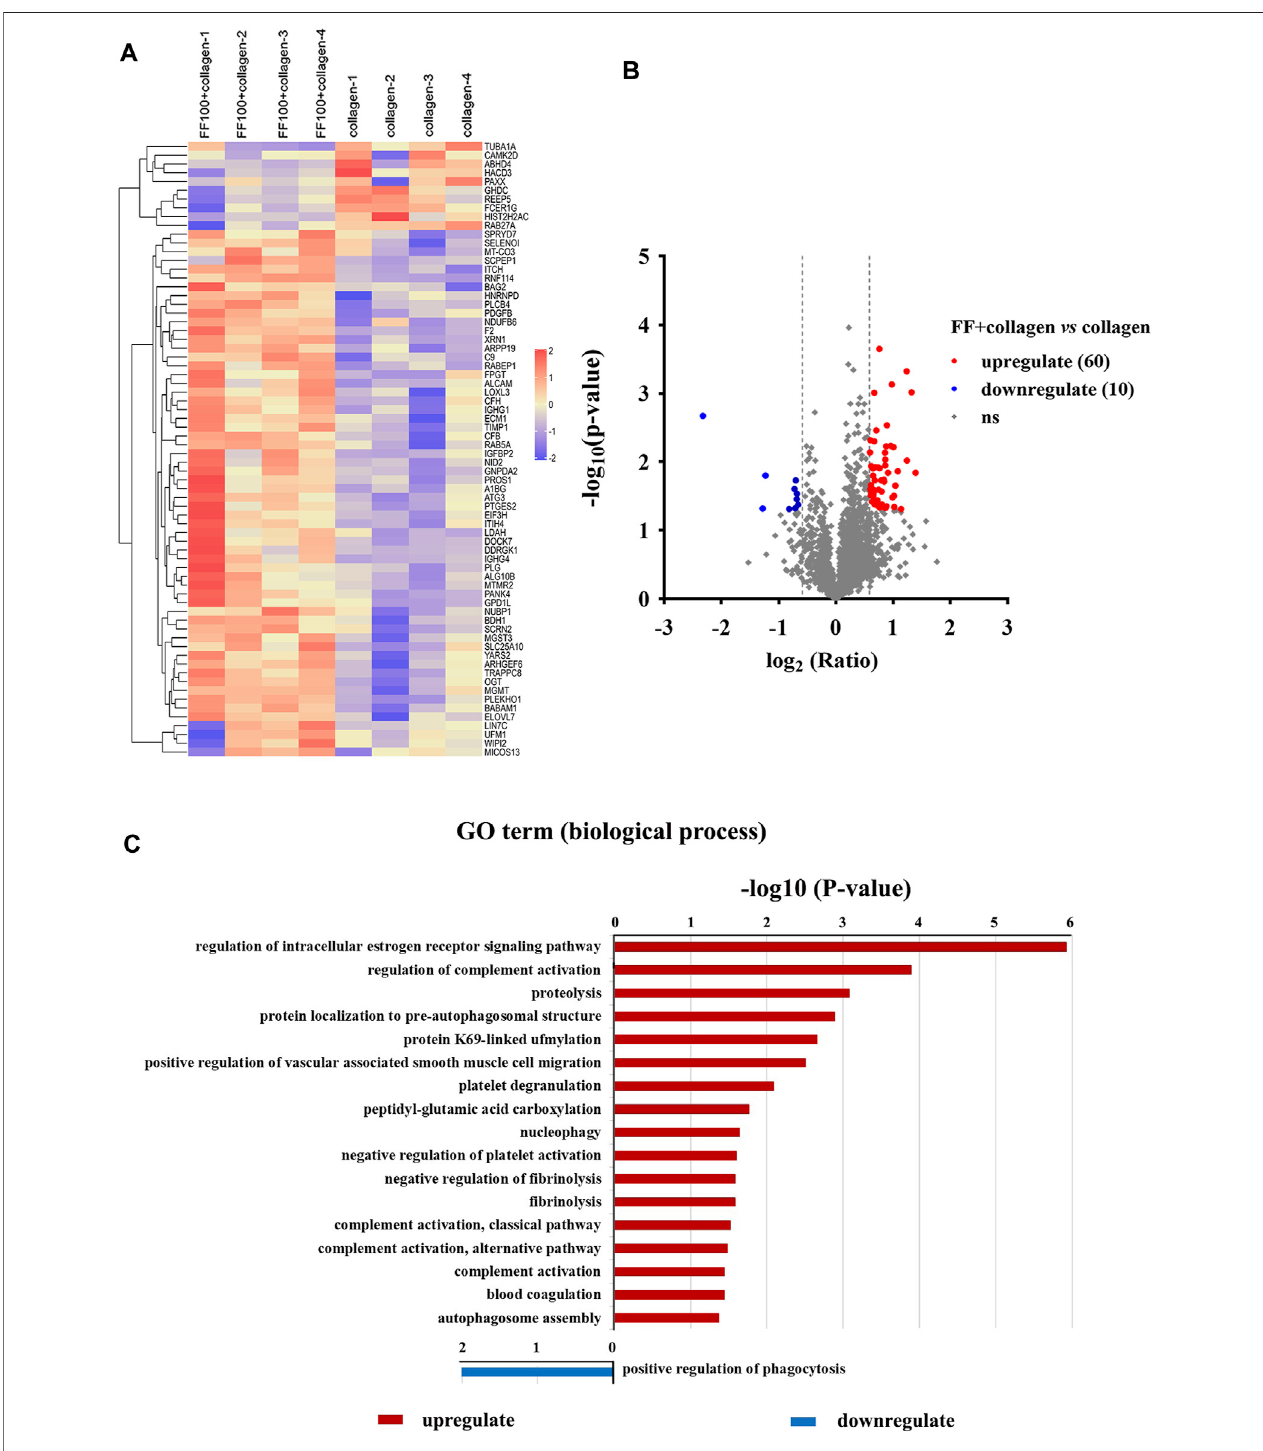
FIGURE 2 | Identi fi cation of proteins with and without FF treatment in collagen-stimulated platelets. Washed human platelets were incubated with FF (100 μ g/ml) for 10 min, and then collagen (5 μ g/ml) was added for 10 min. (A) Heatmap of the identi fi cation and quanti fi cation of proteins in FF-treated collagen-stimulated platelets and collagen-stimulated platelets alone. (B) Volcano map of the identi fi cation and quanti fi cation of proteins in FF-treated collagen-stimulated platelets and collagen- stimulated platelets alone. Red, blue, and gray clusters indicate up-, down-, and unregulated proteins, respectively. (C) Biological processes identi fi ed by Gene Ontology enrichment analysis of collagen-stimulated platelets with and without FF treatment.